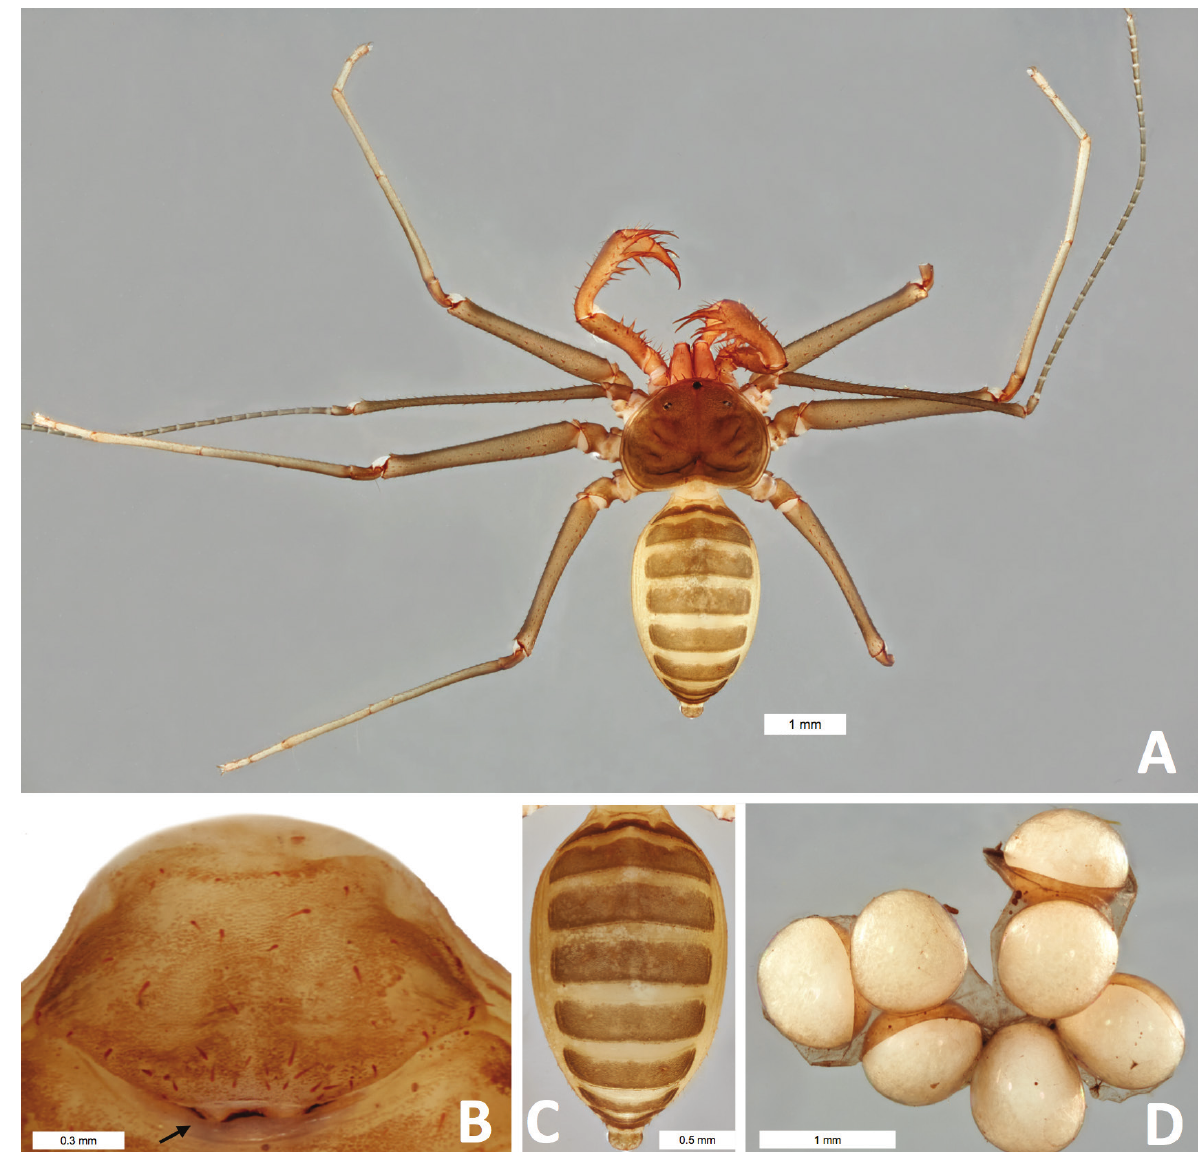
Figure 2. Female holotype of Charinus kakum sp. n.: A , habitus dorsal; B , genital operculum in ventral view. Arrow indicates the position of the ventral sac covers; C , opisthosoma in dorsal view; D , eggs carried by the female (removed from the genital opercu- lum for